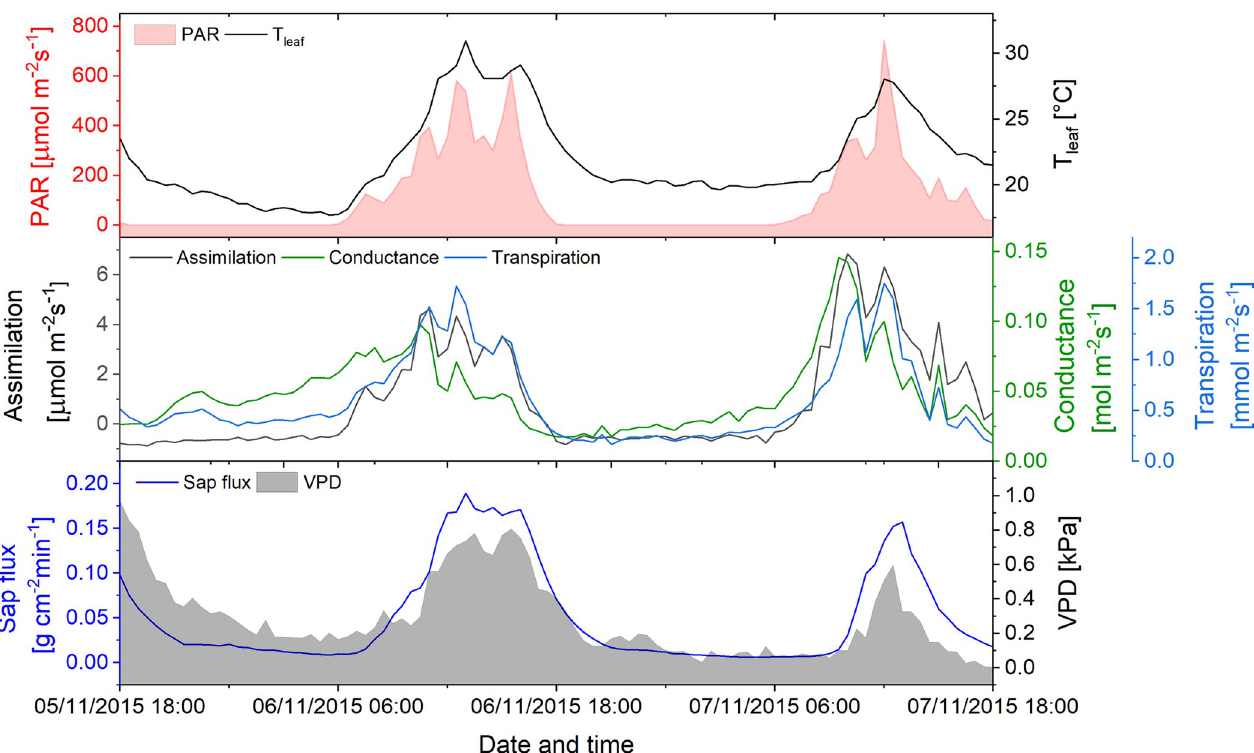
Fig 6. Gas exchange on the background of microclimate parameters (VPD–shadowed in grey, PAR–red area) of a leaf in the sun crown of Tapirira guianensis , measured over 2 days (November 5–7, 2015) under simulated natural atmospheric conditions with the IRGA. Simultaneously, sap flux was measured in the stem at breast height (lower